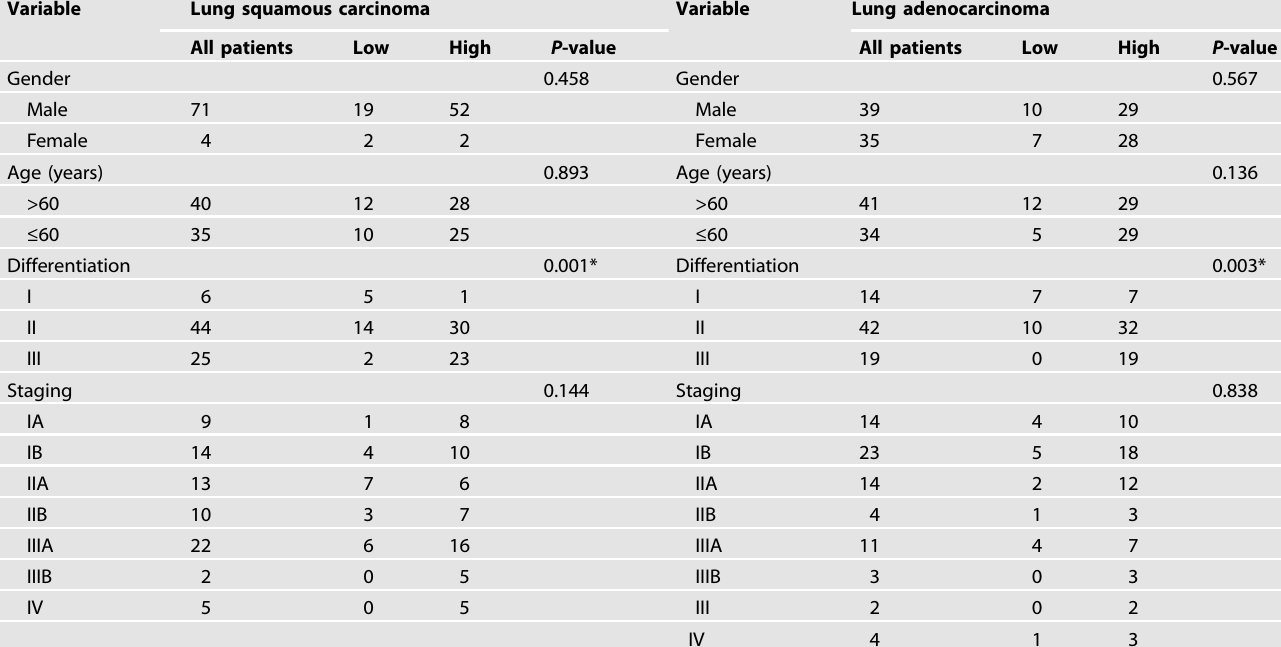
Table 2. Correlation of FASN expression to clinicopathological characteristics of lung cancer